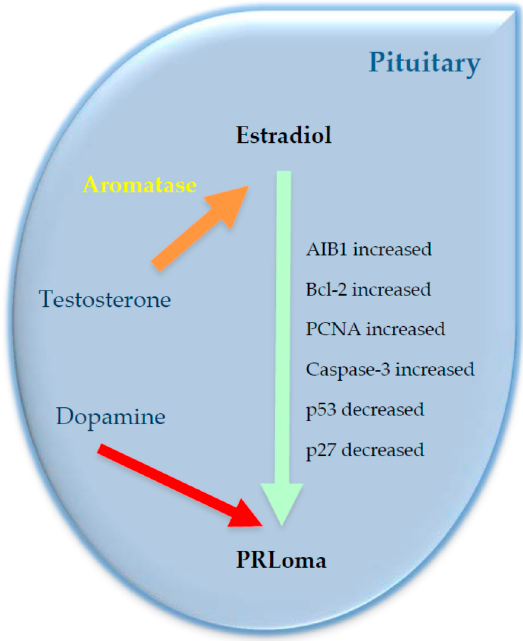
Figure 1. Schematic diagram of the relation among aromatase P450 and growth markers in prolactinomas. Dopamine and steroids are regulators of prolactin production. Dopamine suppresses the prolactin release (red arrow: inhibition), while estradiol is an important regulator of prolactin synthesis (blue arrow: stimulation). The conversion of testosterone to estradiol is mediated by aromatase (orange arrow: stimulation). When some markers present inadequate regulation or their intracellular localization altered, they can lead to an overexpression of aromatase and trigger prolactinomas. In prolactinoma, AIB1, Bcl-2, and proliferating cell nuclear antigen (PCNA) markers are increased and Caspase-3 p53 and p27 are decreased (Modified of [73]).